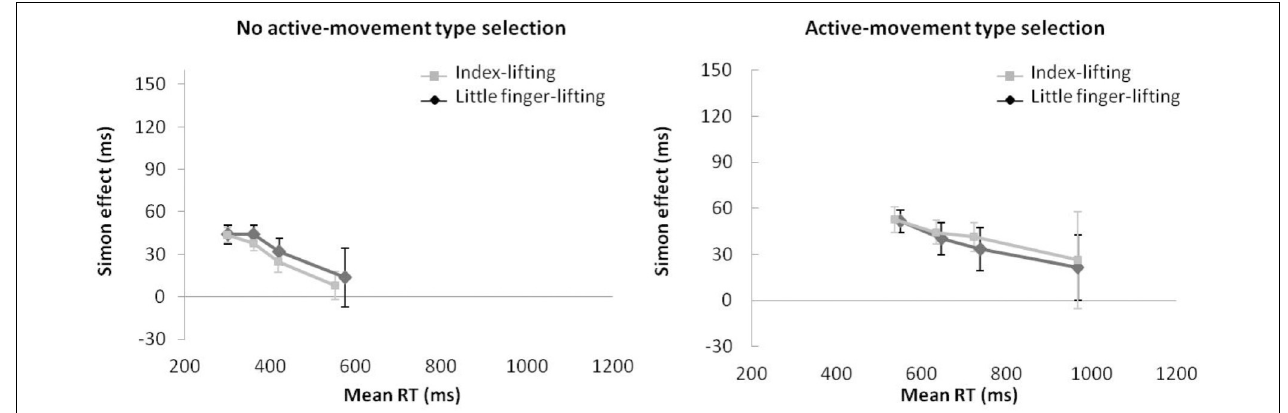
FIGURE 11 | Delta-plots showing Simon effect magnitudes as a function of response speed (expressed in reaction time quartiles) for index-lifting and little finger-lifting actions within the no active-movement type selection condition (Left) and active-movement type selection (Right) in Experiment 4. Error bars represent the standard error of the mean.